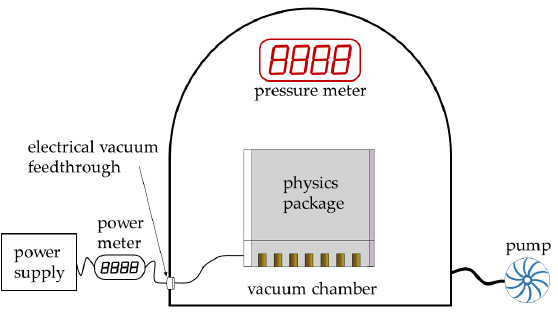
Figure 4. The measurement setup of power consumption under different pressure.